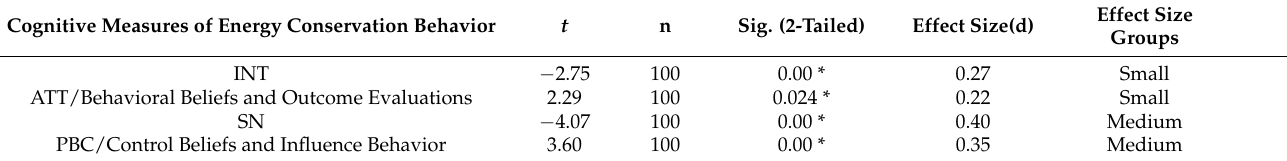
Table 11. Results of the Paired Samples t -tests between Pre-feedback and interventions and Post- feedback Scores of the Experimental